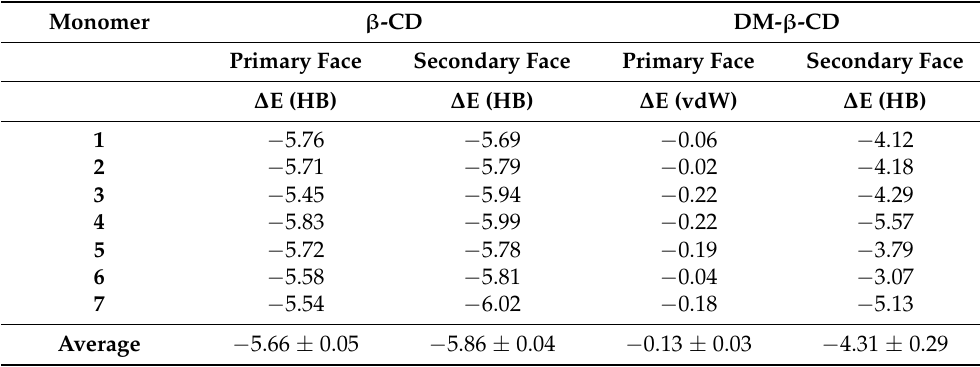
Table 1. Intramolecular interaction energies (in kcal/mol) within β -CD (left) and DM- β -CD (right), calculated from the electron density at the critical bond points. The standard error of the mean was calculated for both faces of both